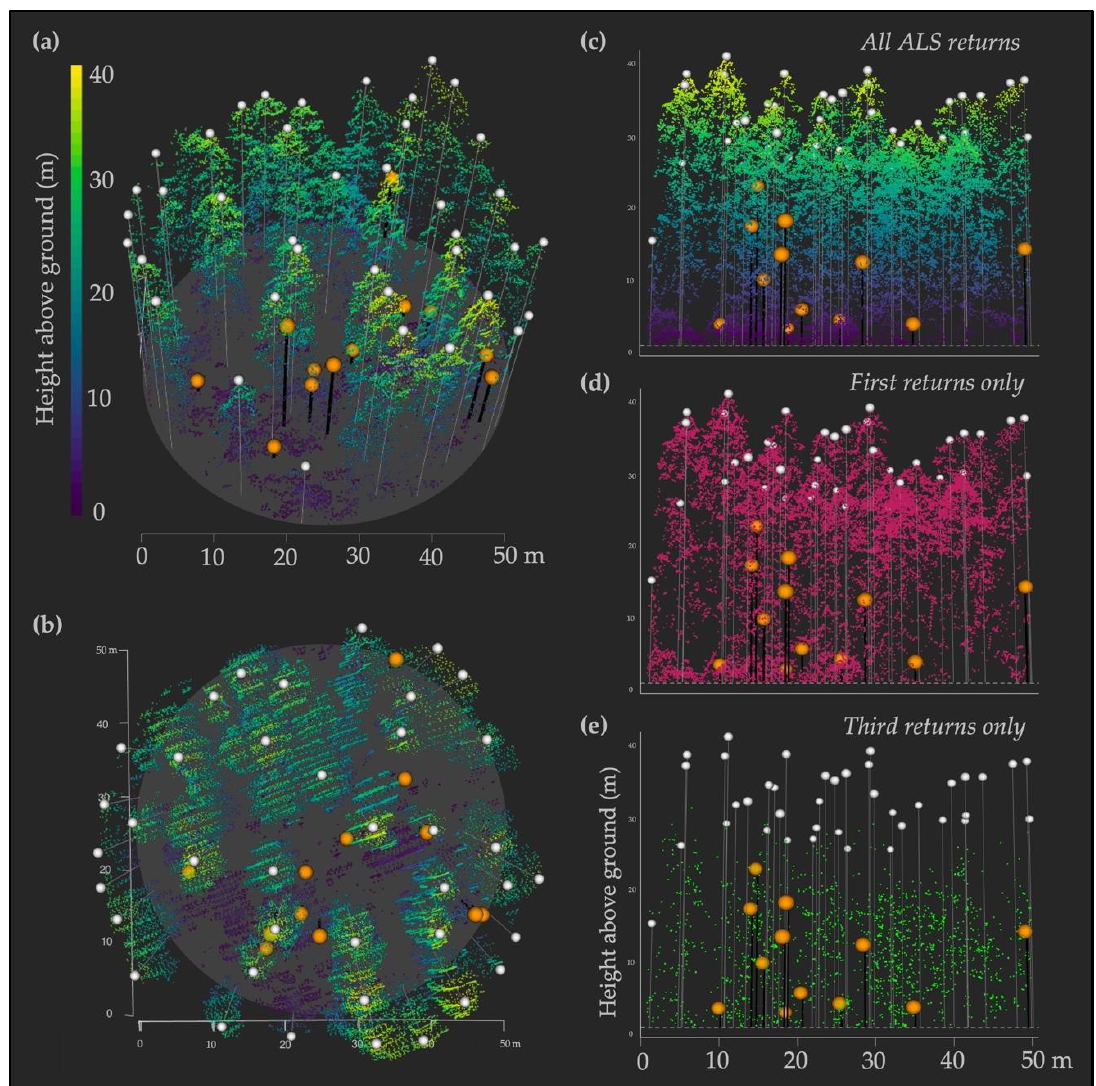
Figure 3. Example of a 50 m diameter IPNF survey plot illustrating variability in point densities. Snags and live trees are overlaid on the ALS point cloud of a representative survey plot (with points below 1.37 m omitted), where orange circles with black lines represent snag locations and heights, and white circles with white lines represent live tree locations and heights. Multiple views of the same point cloud are shown to illustrate different aspects of interest: ( a ) plot viewed from an angle to best show stand structure and individual tree canopies and spacing; ( b ) plot viewed from directly above (at nadir) to best show parallel scan angles, variations in point density, snag and gap distributions, and the absence of returns around multiple snags; ( c – e ) plot viewed from ground level to best show tree heights and ALS returns across three versions, where ( c ) includes all returns (colored by height) to highlight a relatively uniform point distribution across vertical heights, as well as show that nearly all live trees were in the upper strata of heights relative to snags; ( d ) includes first returns only to highlight the notably greater first return densities in the upper canopy; and ( e ) includes third returns only to highlight that the majority of third returns fell within the midcanopy range, below live tree